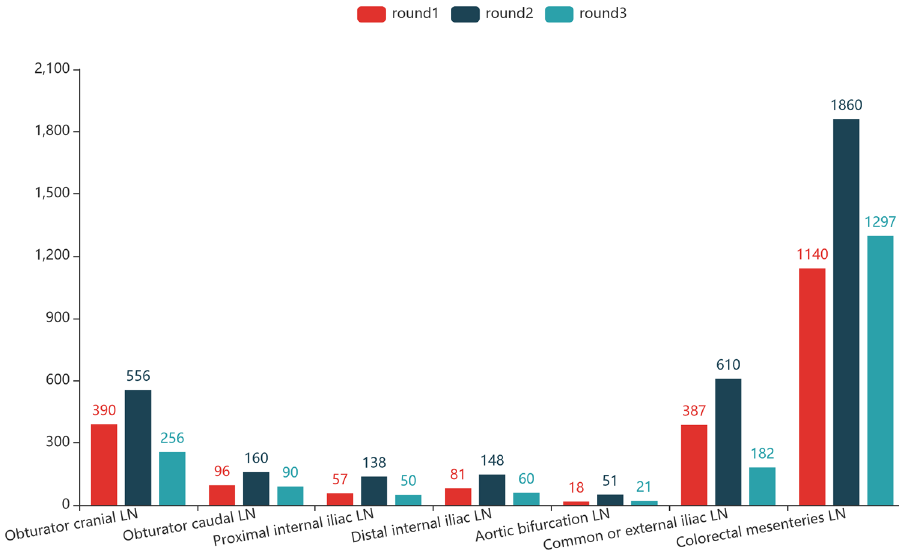
Figure 12. Partition distribution of annotated lymph nodes.